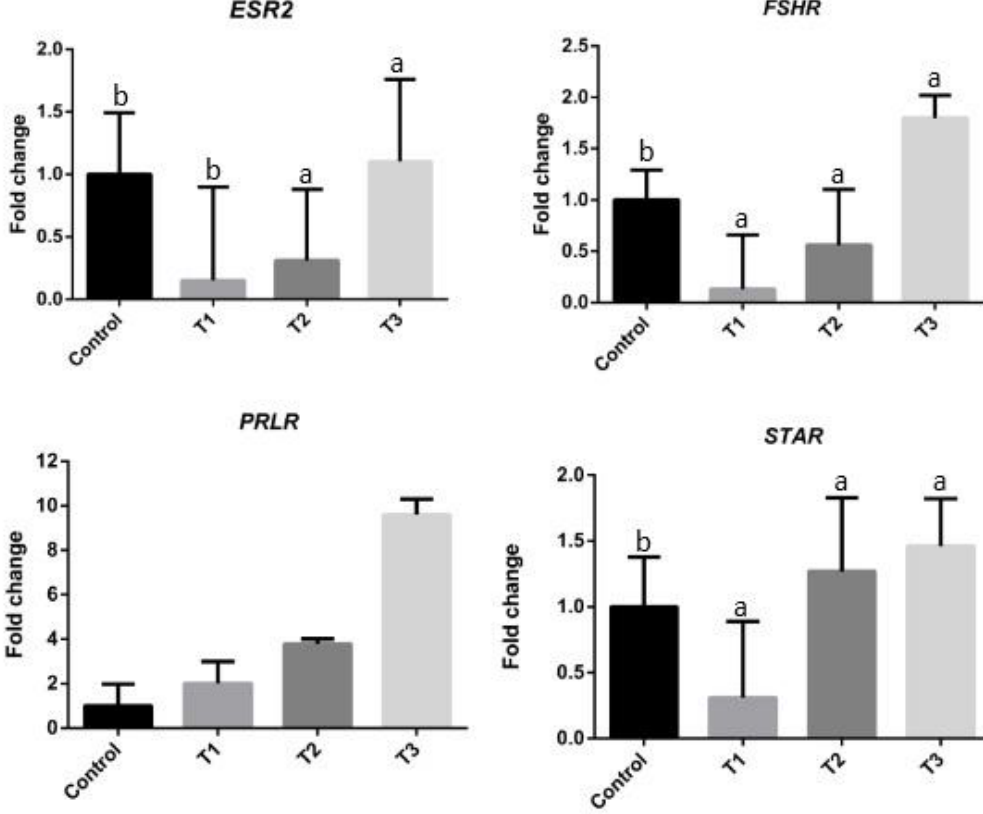
Figure 1. The relative expression levels of ovarian genes ( ESR2 = estrogen receptor 2 (ER beta) , FSHR = follicle-stimulating hormone receptor, PRLR = prolactin receptor, and STAR = steroidogenic acute regulatory protein) in quail, with different treatments. Letters a, and b on the data bars indicate when p > 0.05 significant. CNT (control), T1 (basal diet supplemented with 0.1% Moringa oleifera seed powder), T2 (basal diet supplemented with 0.2% Moringa oleifera seeds powder), and T3 (basal diet supplemented with and 0.3 % Moringa oleifera seeds powder).